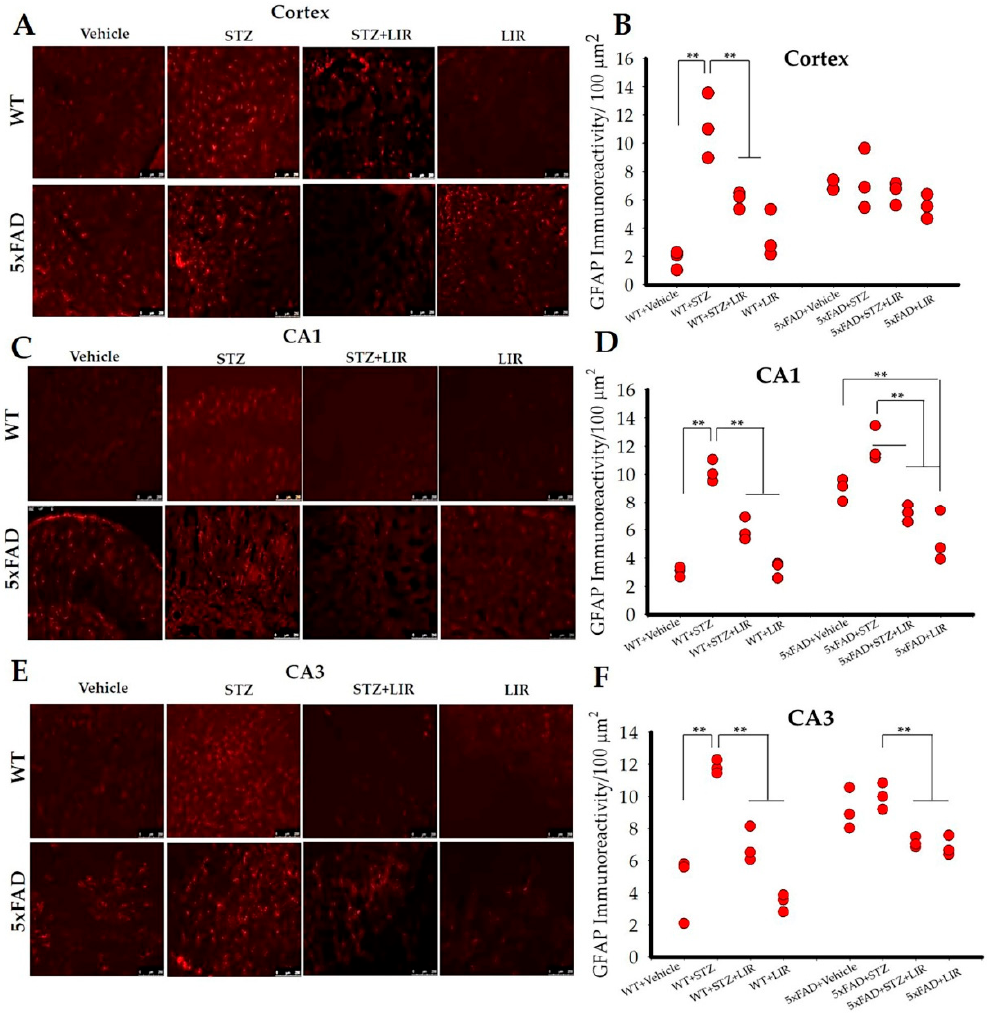
Figure 2. Glial fibrillary acidic protein (GFAP) immunoreactivity in the cortical, and hippocampal CA1 and CA3 regions of WT and 5xFAD mice. Following 30 days of LIR injections, WT and 5xFAD mice ( n = 3 from each group) were sacrificed and perfused transcardially with 4% paraformaldehyde. The brains were removed and sectioned at 30 µ m on a cryostat and the sections were immunolabelled with GFAP antibody. ( A , C , E ): Photomicrographs showing immunoreactive (IR) astrocytes (red) in the cortical, CA1 and CA3 regions of hippocampus in the wild type and 5xFAD mice. ( B , D , F ): Histograms representing GFAP-IR/100 µ m 2 in all the groups of the cortical, CA1 and CA3 hippocampal regions of WT and 5xFAD mice. Data from three different mice in each group were expressed as mean ± SEM; Scale bar is 250 µ m for all images. ** p <